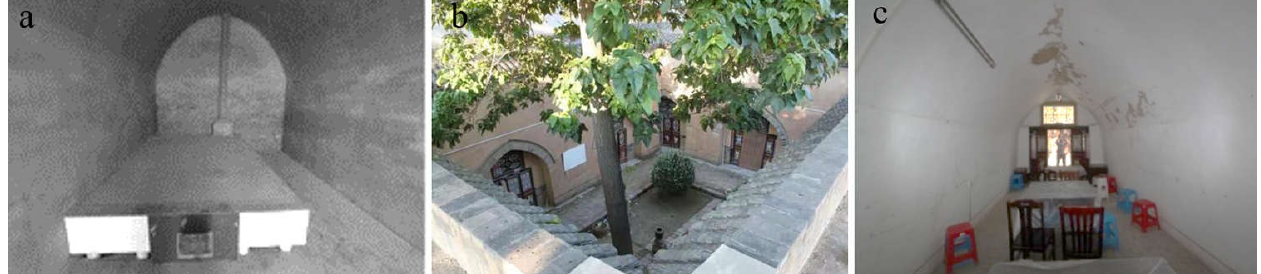
Figure 6. Photos of the selected underground cave dwelling: ( a ) Kang; ( b ) courtyard; ( c ) cave room. Table 1. Thermal properties of envelopes.